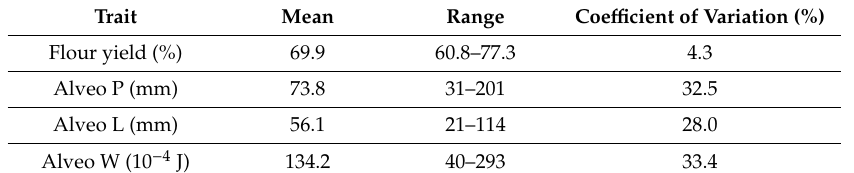
Figure 1. Distribution of phenotypes. ( a ): Flour yield, ( b ): Alveo P (dough tenacity), ( c ): Alveo L (dough extensibility), ( d ): Alveo W (dough strength). Table 1 . Mean, range, coefficient of variation of phenotypic data.